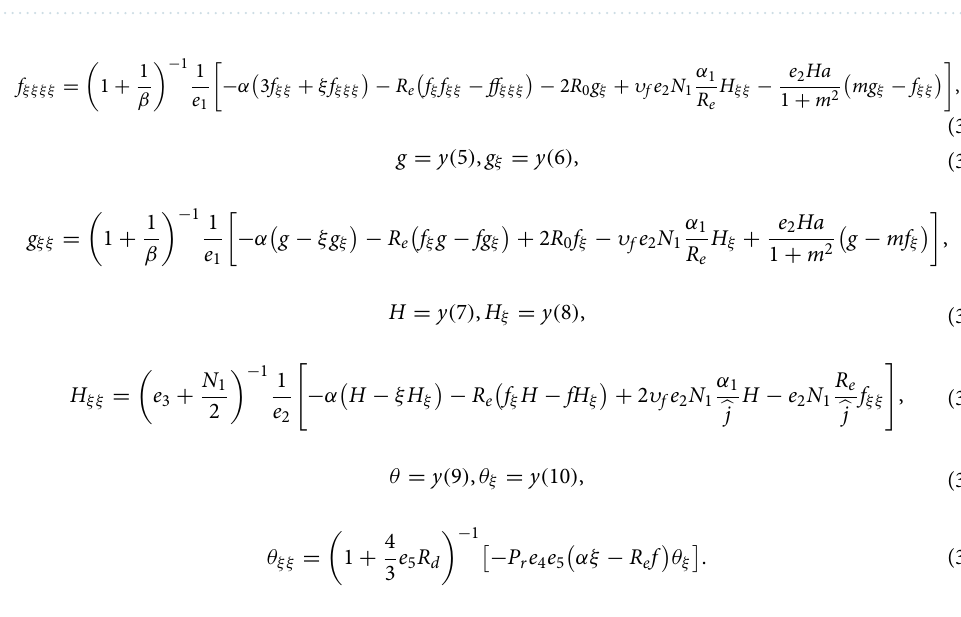
Figure 2. Flow chart of tri-hybrid